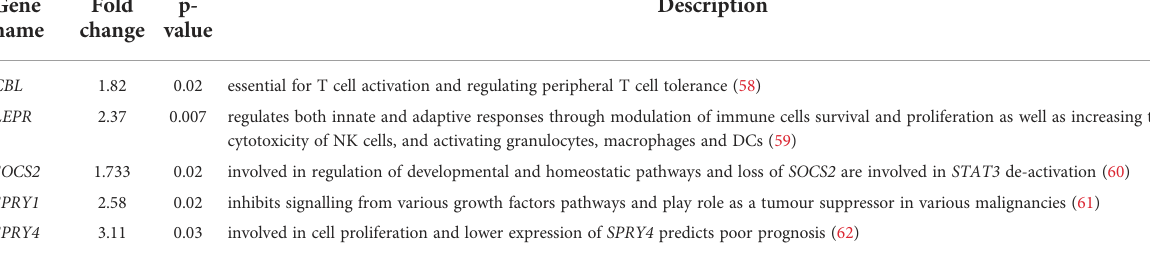
TABLE 2 Jak-Stat pathway genes and their